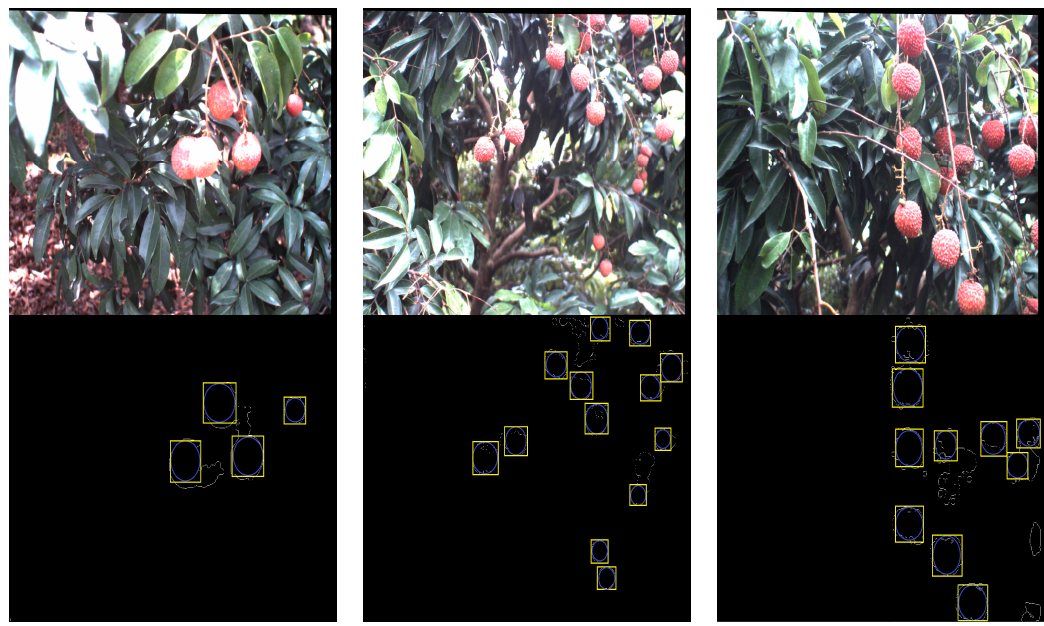
Figure 14. The extraction results of mature litchi fruits including missed clustered litchi fruit. The ( top ) row were the original litchi color images; the ( bottom ) row listed the corresponding extraction results of mature litchi fruits but including missed clustered litchi fruit. Table 1. The recognition results of the proposed method.